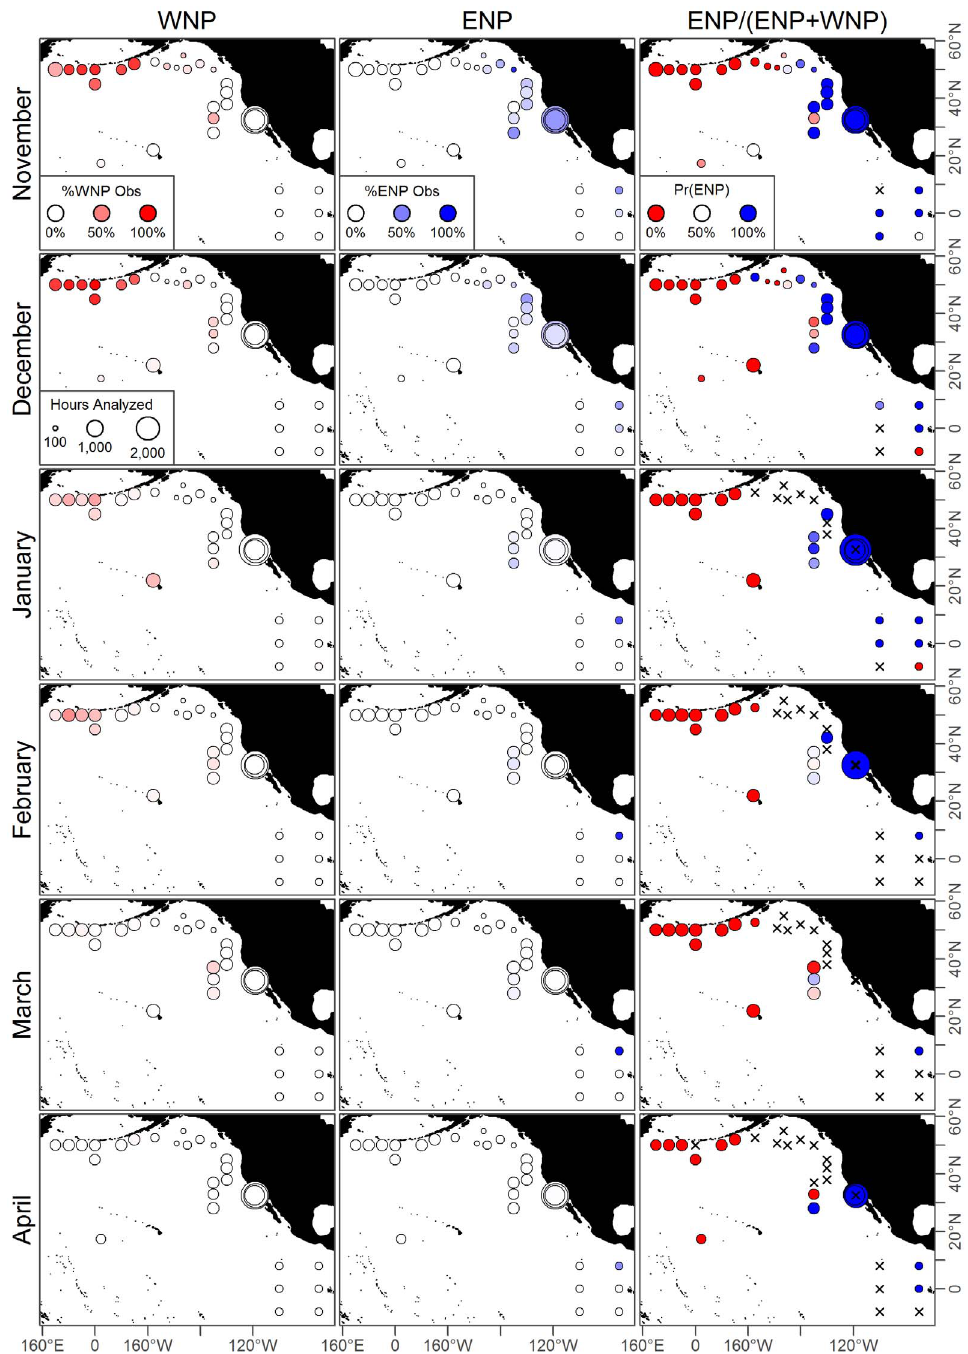
Figure 5. Observed hydrophone data for November-April. Caption as for Figure 4. (1) estimated the presence or absence of each population in space and time and then (2) predicted the probability a catch belonged to the ENP population. The first stage fitted a spatial surface separately to the ENP and WNP populations based on the monthly call rates. These two independent ‘acoustic models’ predicted the probability of observing at least one song call in an hour at a given location and time. In the second stage the two acoustic models were combined together into a single ‘prediction